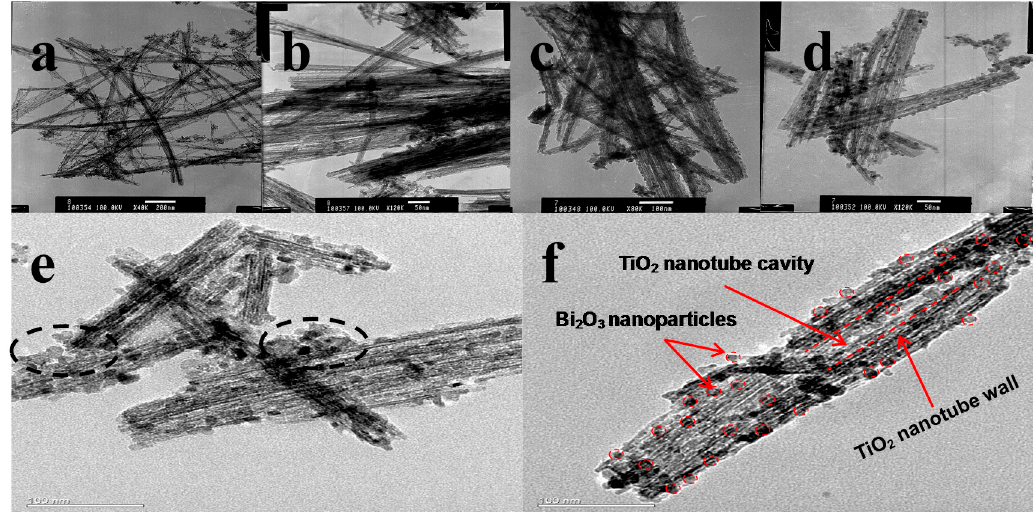
Figure 4. TEM and HRTEM images of the prepared samples. ( a , b ) Neat TiO 2 nanotubes; ( c – f ) Bi 2 O 3 -sensitized TiO 2 nanotubes. The detailed structural features are highlighted with red circles and lines in ( f ).